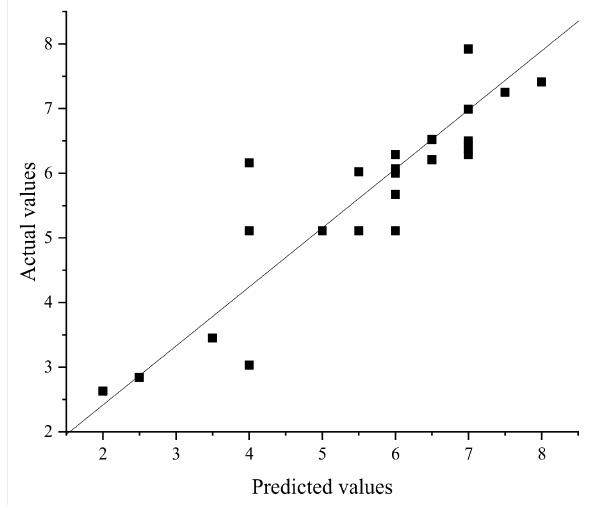
Figure 21. Comparison of predicted and actual values by GFA (r 2 = 0.861). Table 5. Comparative analysis table between predicted and actual